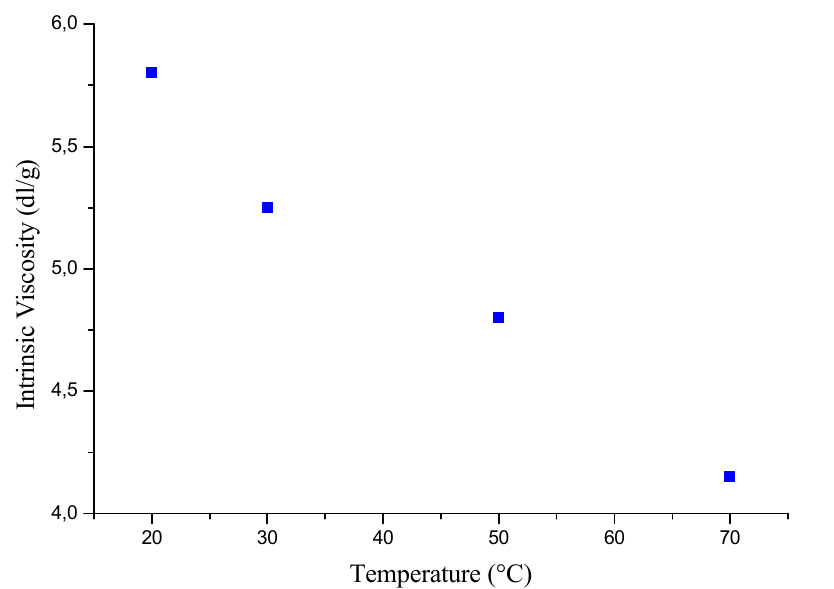
Figure 8. Effect of the temperature on the intrinsic viscosity of formed polymers.